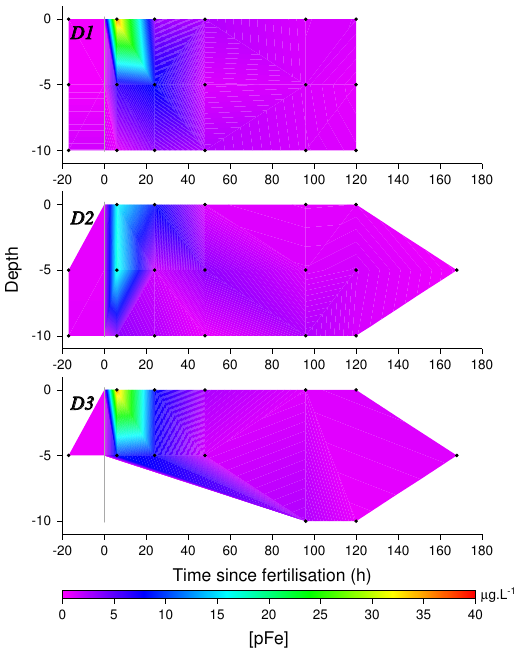
Fig. 2. Evolution of pFe concentrations ([pFe] in µgL − 1 ) during the DUNE-1-P experiment in mesocosms D1, D2 and